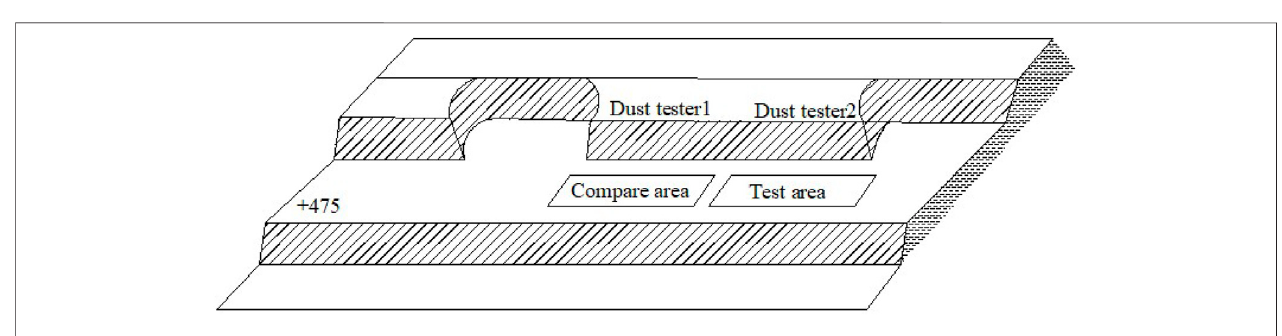
FIGURE 14 | Layout of test area and comparison area.